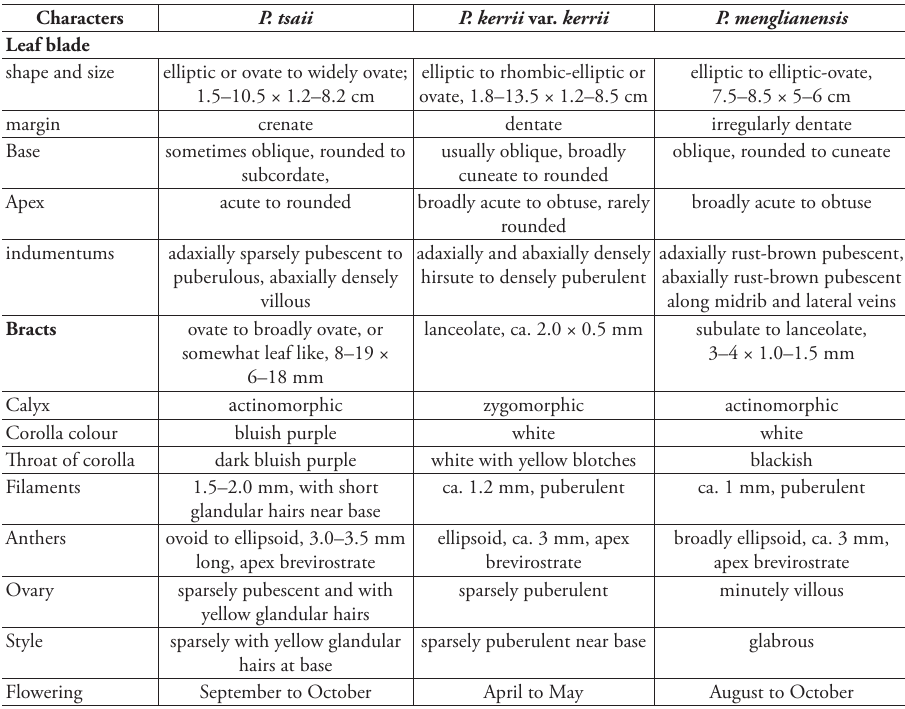
Table 2. Morphological comparison among Petrocosmea tsaii sp. nov., Petrocosmea kerrii Craib var. kerrii and Petrocosmea menglianensis H. W.